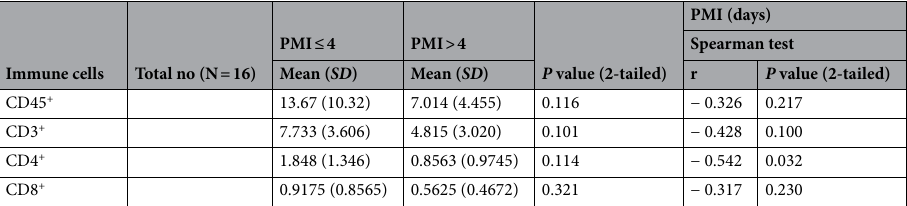
Table 1. A comparison of PMI values (in days) and colonic mucosal immunophenotype. PMI post-mortem interval, SD standard